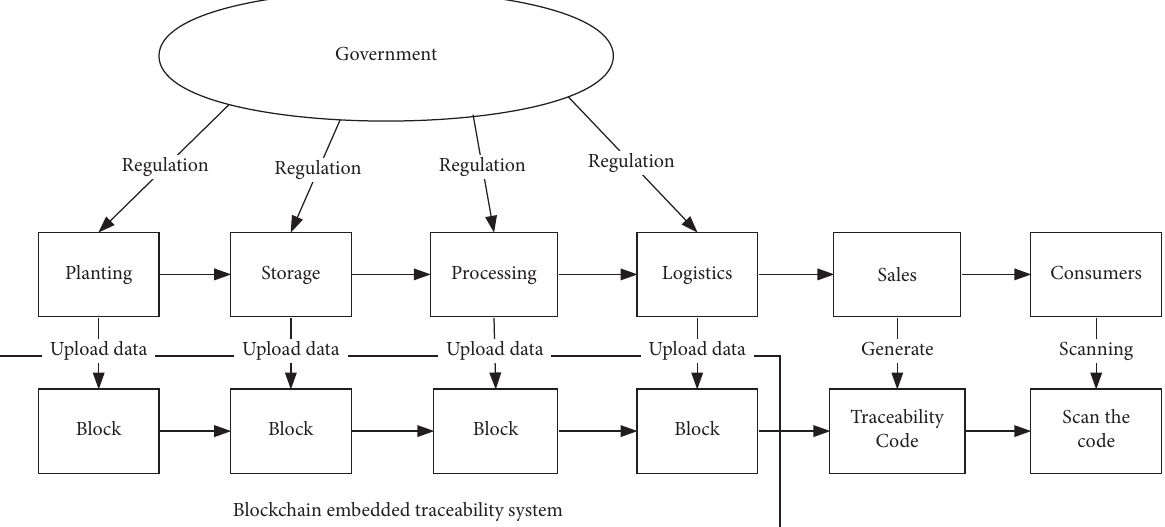
Figure 2: Standardized production of agricultural products embedded in blockchain.